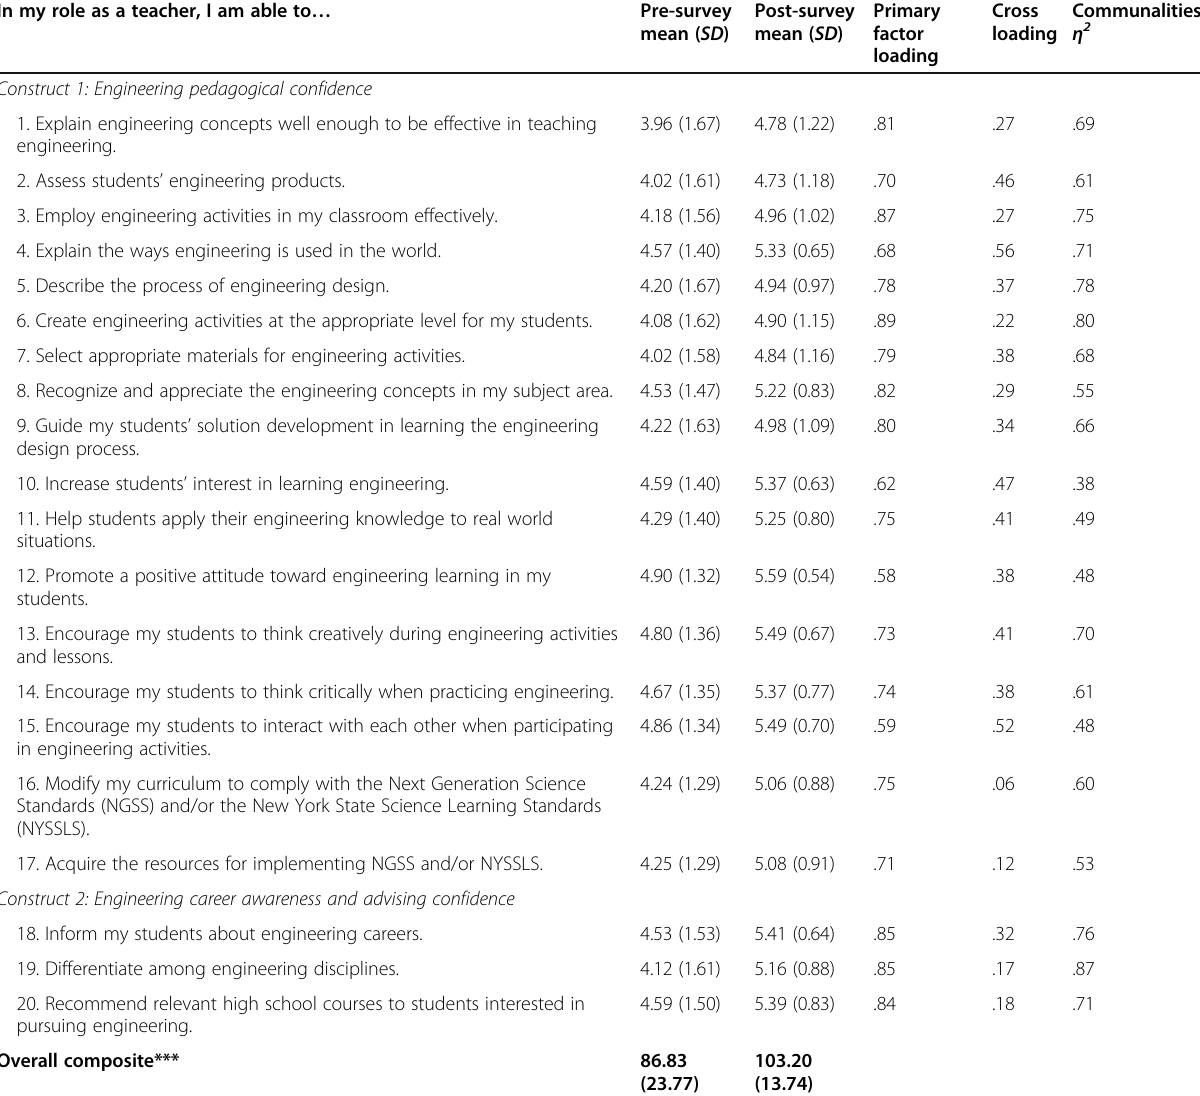
Table 3 Engineering professional development survey results In my role as a teacher, I am able to